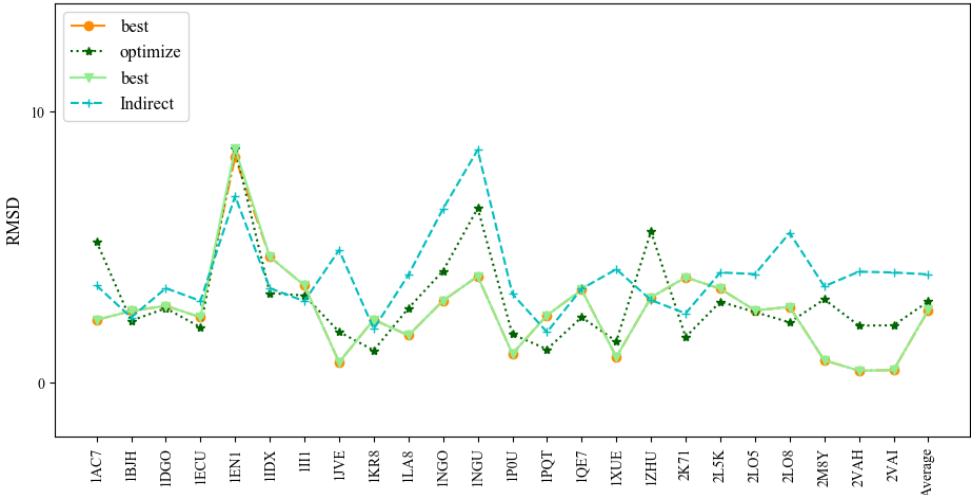
Figure 8. Comparison of the prediction accuracies (all-atom RMSDs) of the assembled, optimized, and best structures of 3dDNA with previous indirect predictions by Jeddi. Table 4. Information and prediction accuracies (RMSD in Å ) of 24 DNAs.